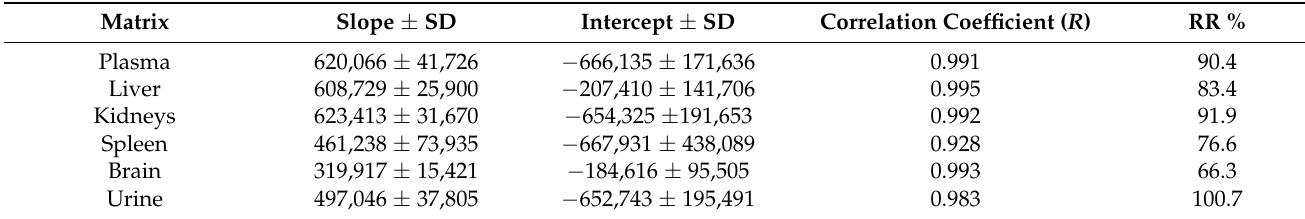
Table 5. AuNP linearity and recovery in mice organs.